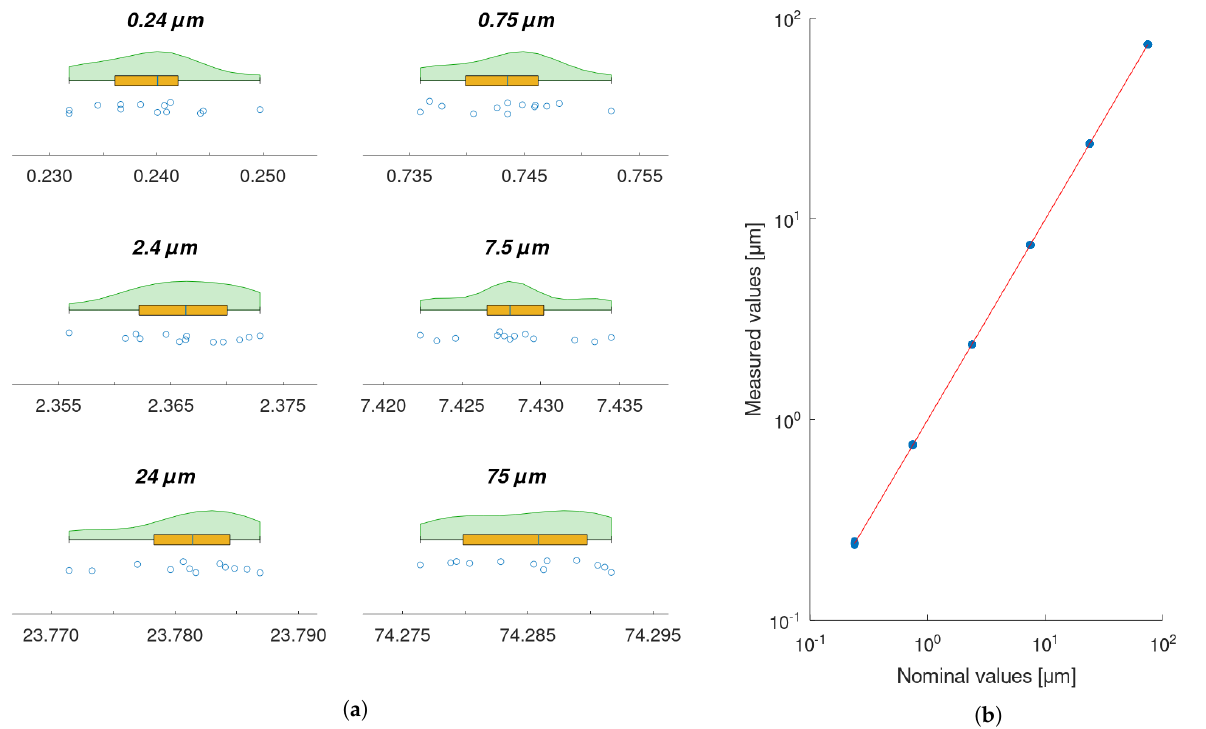
Figure 8. ( a ) Raincloud plots for each piezo actuator displacement being measured with XL-80 interferometer; ( b ) Scatterplot of data points representing the relationship between the required piezo actuator displacement and the displacement being measured with the XL-80 interferometer. The linear regression model is fitted (1 − R 2 = 6.4 × 10 − 8